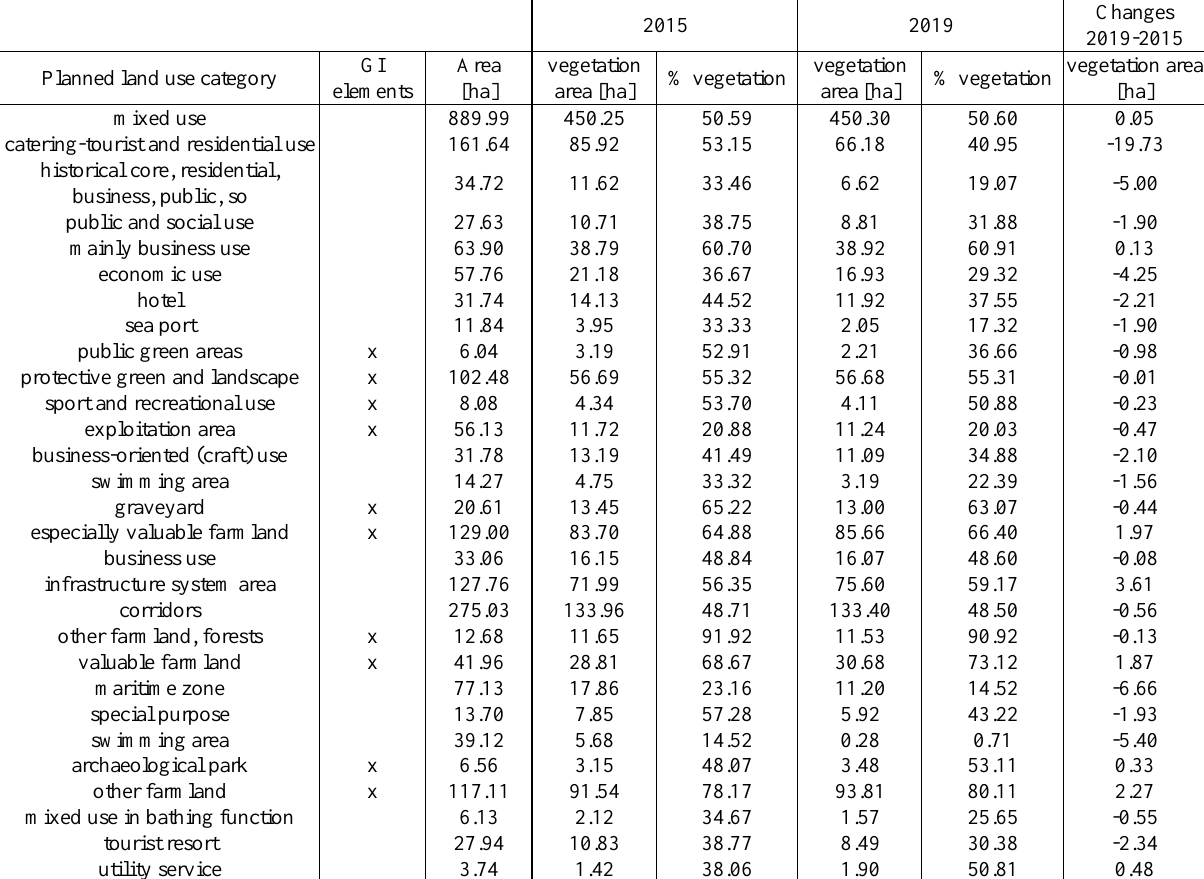
Table 5. The area under vegetation by planned land use zones and vegetation